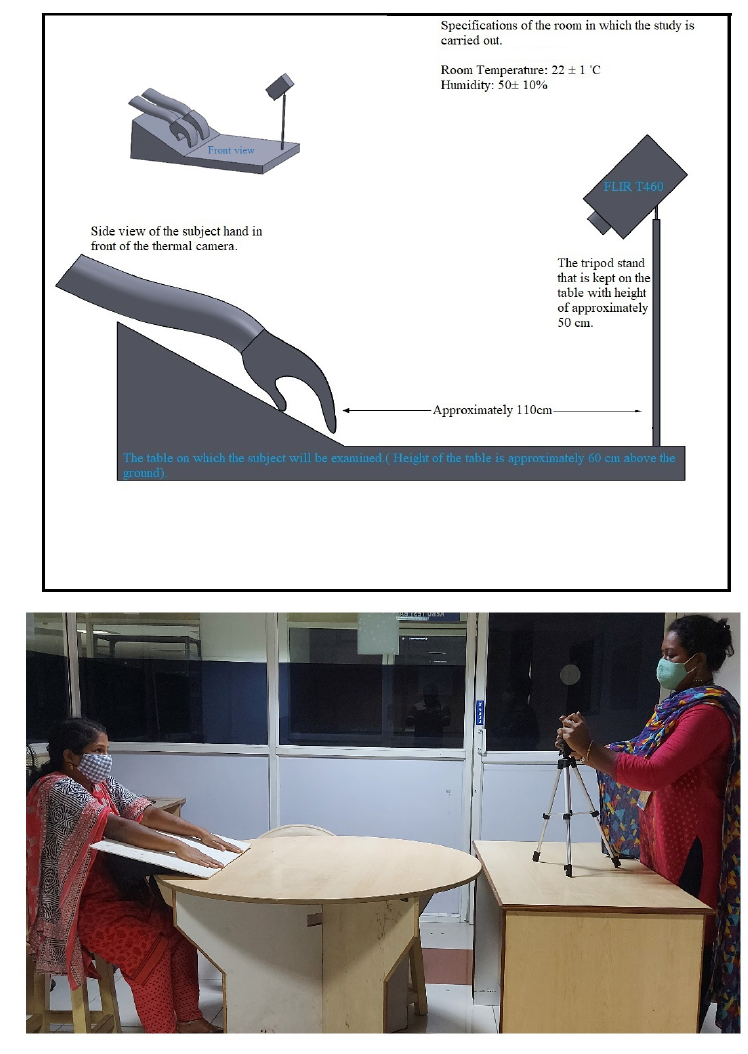
Figure 2. Experimental setup for the